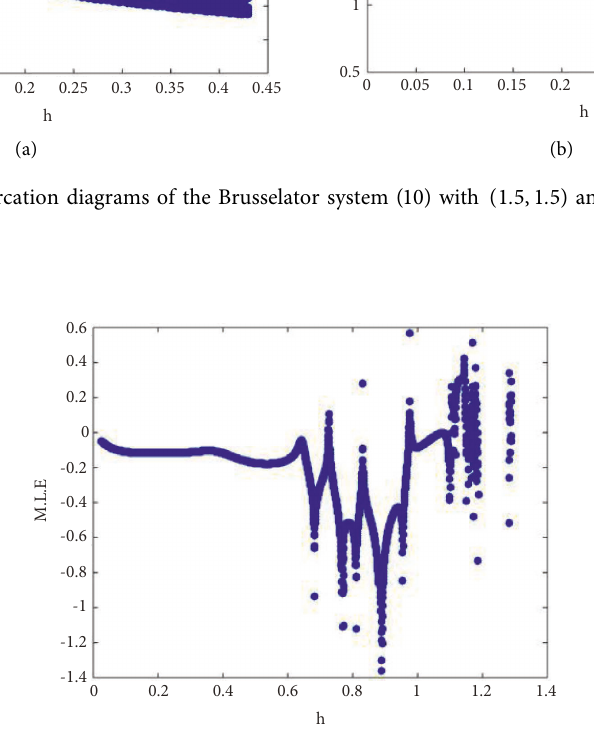
Figure 4: Maximum Lyapunov exponents (M. L. E) corresponding to Figure 3 of the Brusselator system (10).